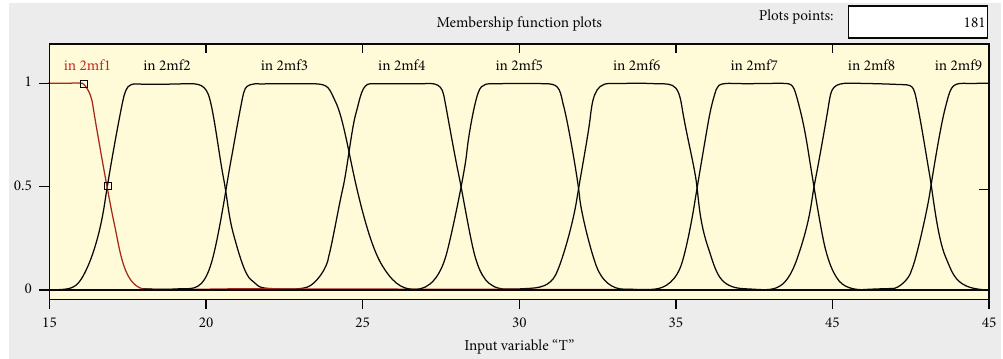
Figure 8: Membership functions of input T